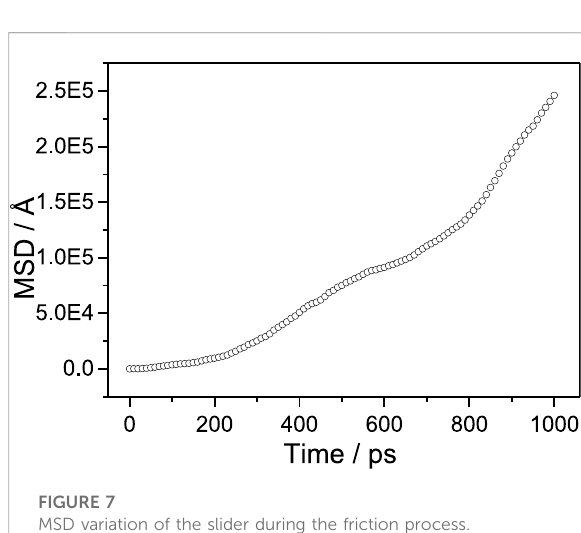
FIGURE 7 MSD variation of the slider during the friction